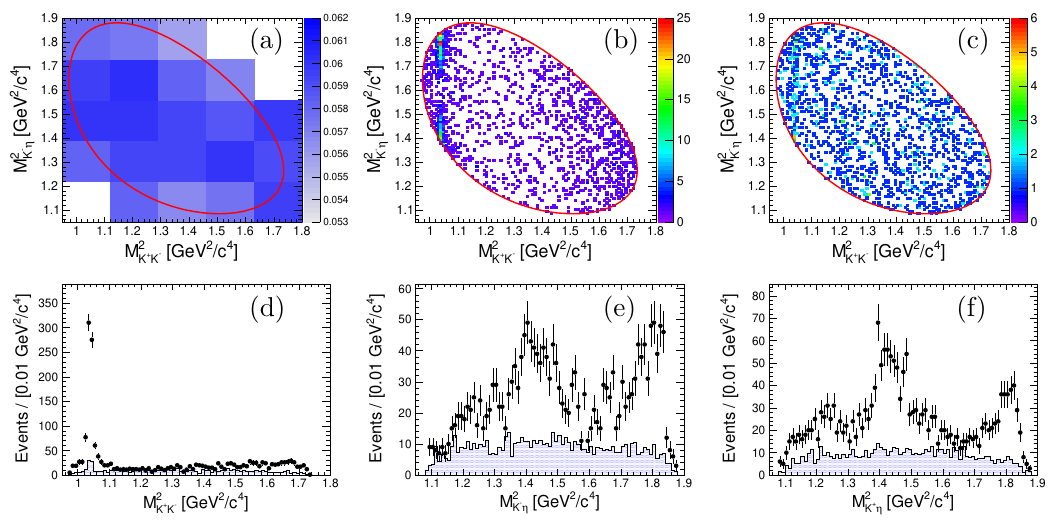
Figure 3 . For D 0 → K + K − η : (a) distribution of reconstruction efficiencies over the Dalitz plot, divided into 5 × 5 bins of M 2 vs M 2 . The red lines indicate the Dalitz plot boundaries. K + K − K − η (b) Dalitz plot for events in the Q signal region | Q − 5 . 86 | < 0 . 80 MeV. (c) Dalitz plot for events in the sideband region 2 . 5 < | Q − 5 . 86 | < 4 . 90 MeV, used to estimate the background shape. (d,